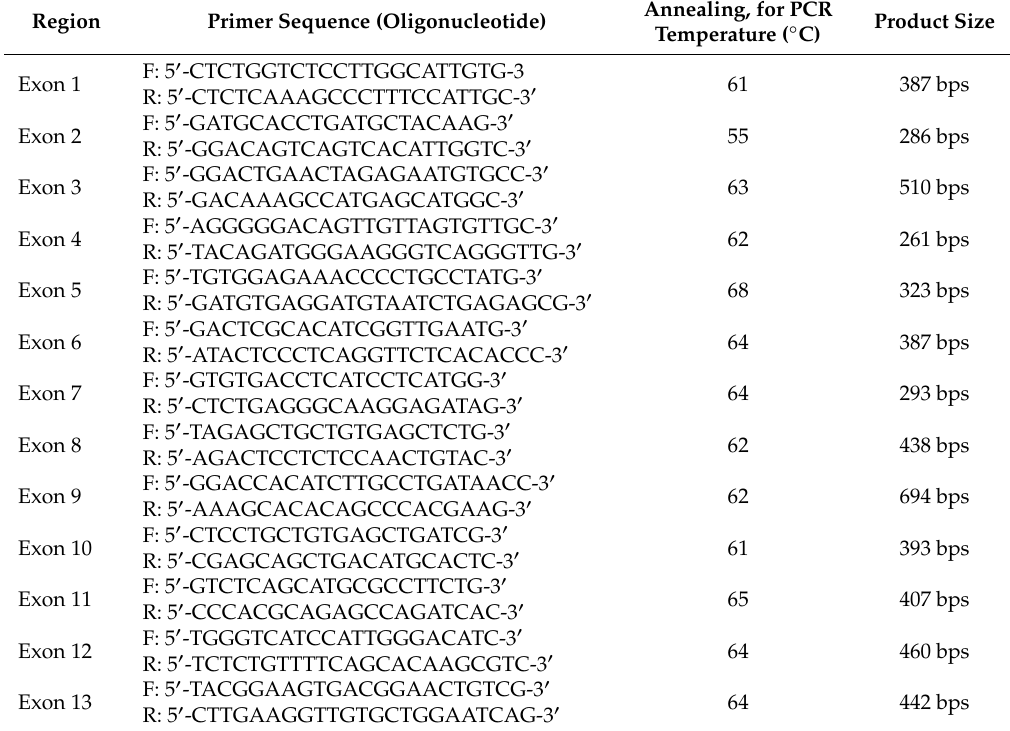
Table 4. Primers of transmembrane protease serine 3 ( TMPRSS3 ) gene for screening in hearing loss and normal hearing